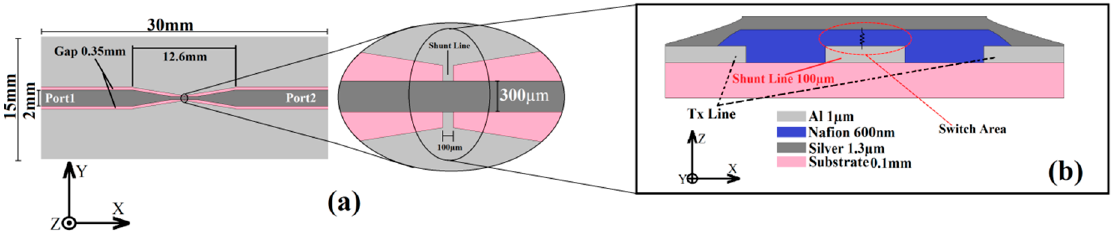
Figure 3. Geometry ( a ) and layer architecture ( b ) used in the co-planar waveguide (CPW) transmission line shunt mode RF-Switch.